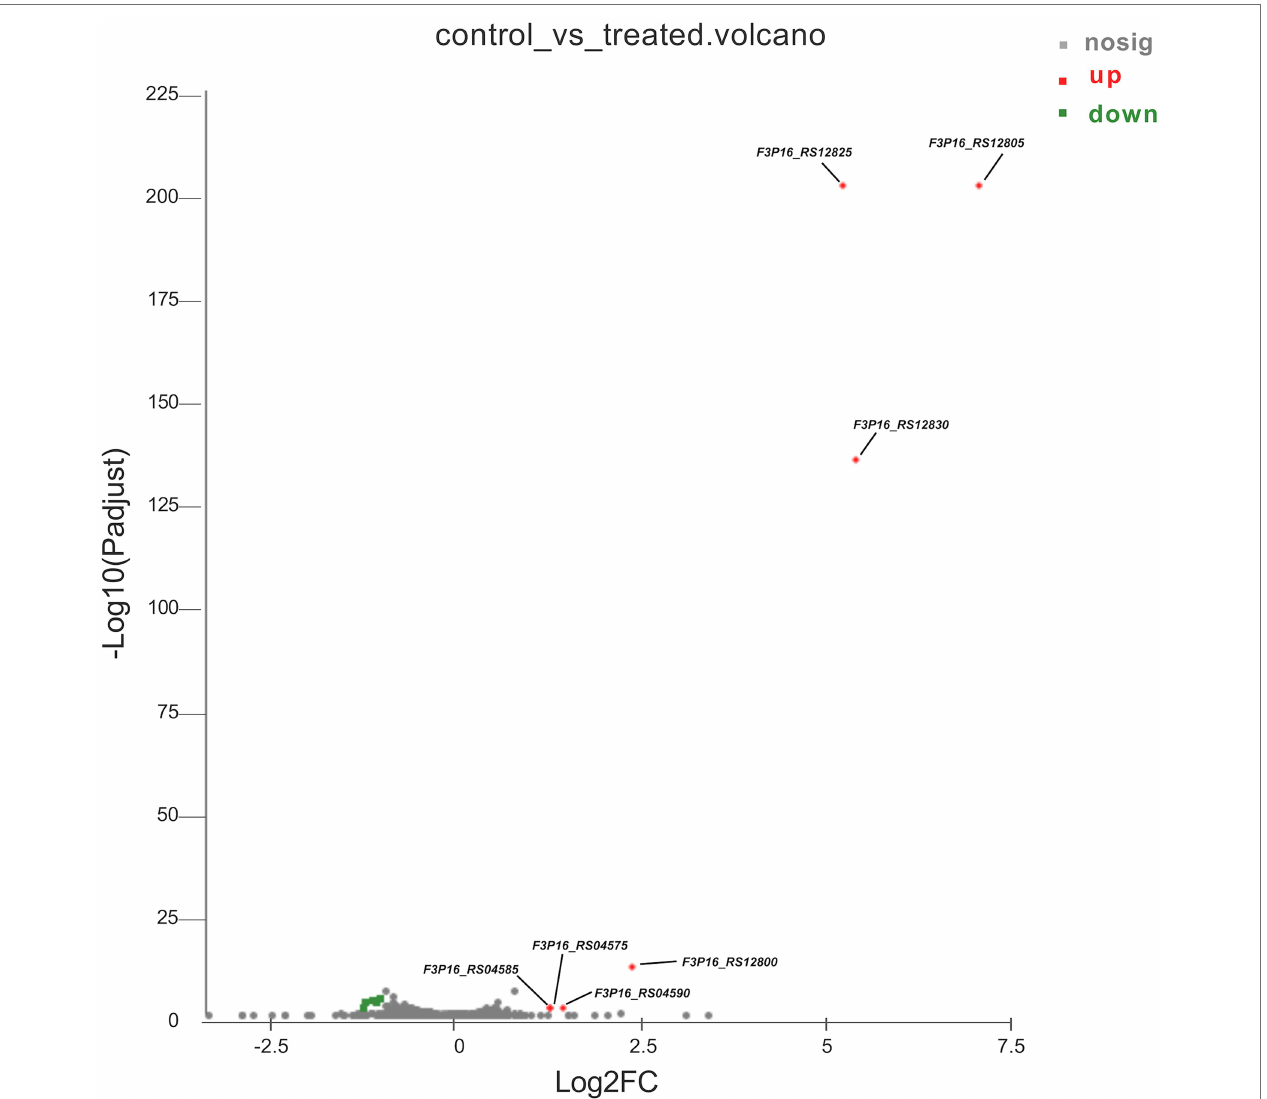
FIGURE 5 | The volcano plot of differentially expressed genes identified by RNA-Seq. The x -axis represents the log 2 (FC), and the y -axis represents –log 10 ( p-adjust ) calculated by the Student’s t -test. The red dots represent the upregulated genes with statistical significance ( p-adjust < 0.05 and |log 2 (FC)| ≥ 1). The green dots represent genes with down-regulated expression, while the gray ones represent genes with no statistical significance. Those upregulated DEGs are indicated. FC, fold